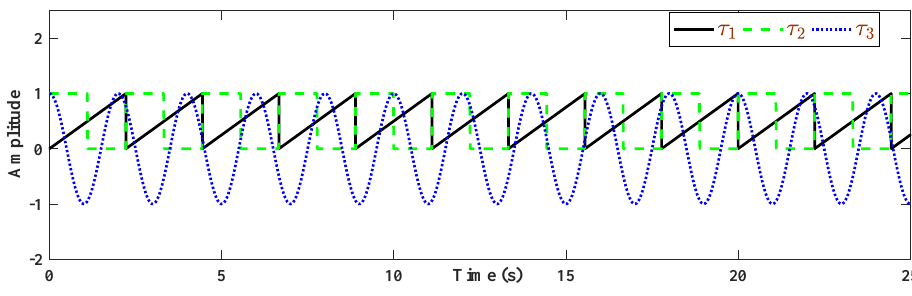
Figure 10. System delays related to Scenario 2. After applying the above values, the system was simulated using Simulink-MATLAB. The obtained results are depicted in Figures 11–17.